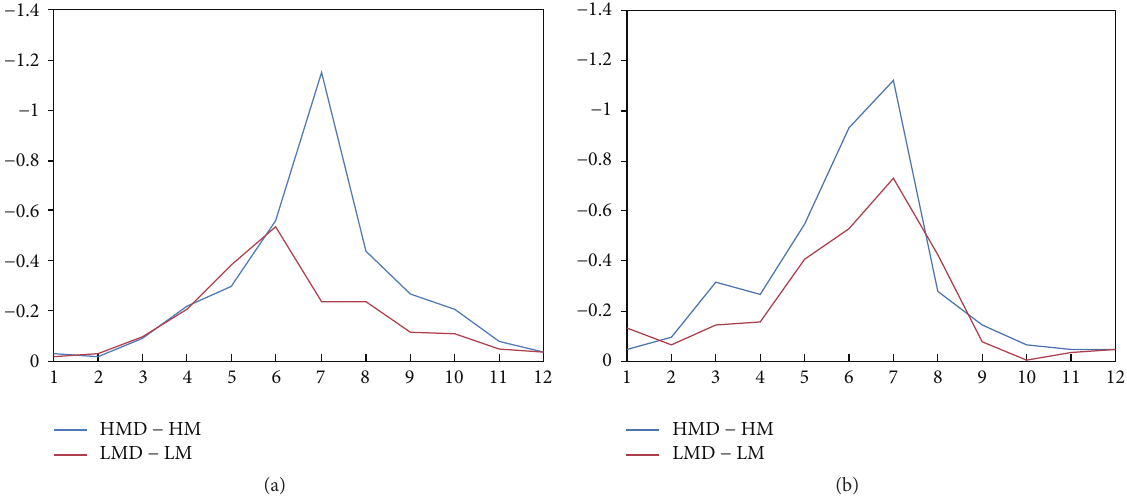
Figure 14: Regional mean precipitation rate (mmday −1 ) averaged in the rainy season (May to August) in north China (a) (38 ∘ –42 ∘ N, 110 ∘ – 120 ∘ E) and south China (25 ∘ –30 ∘ N, 110 ∘ –115 ∘ E) in the four different